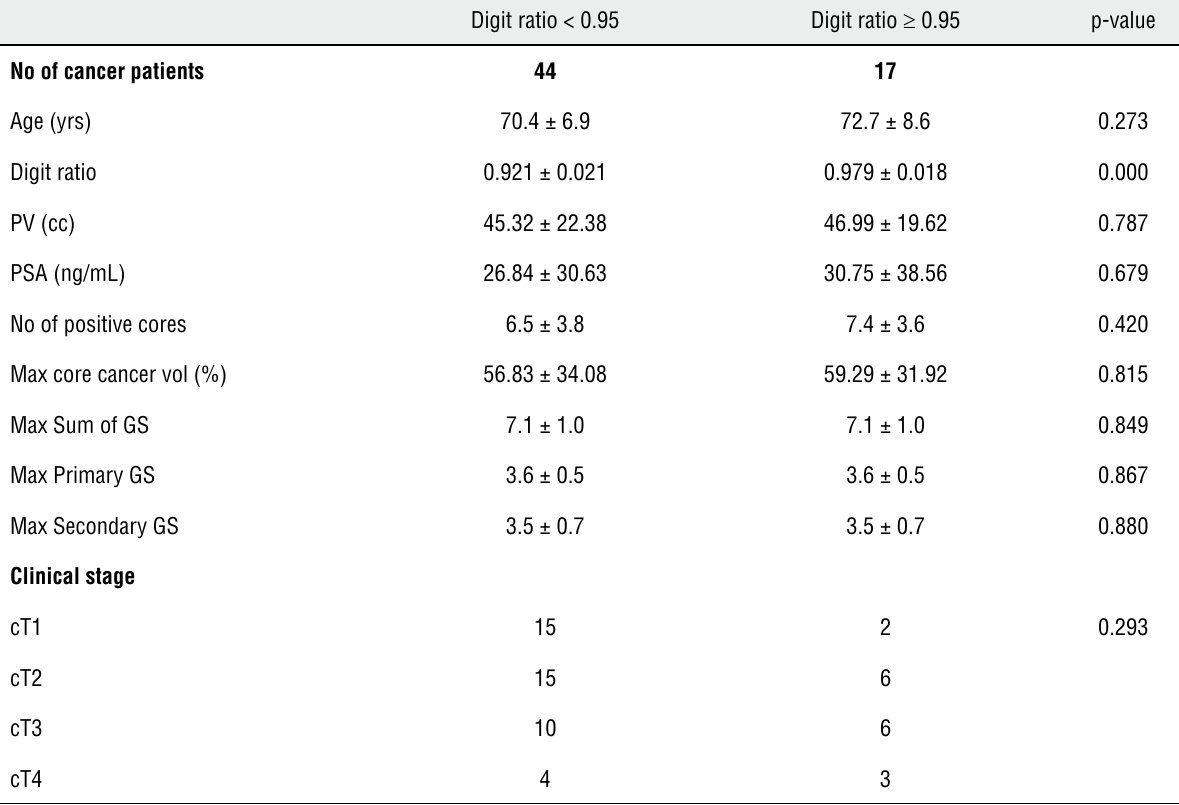
Table 4 - Comparison of the study variables between the two studied